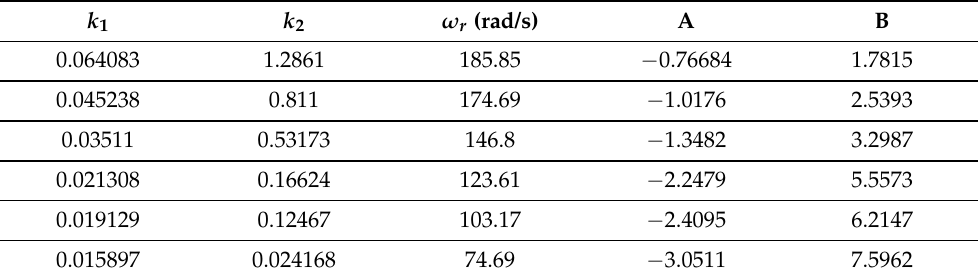
Table 4. Associated gains for every pair (A,